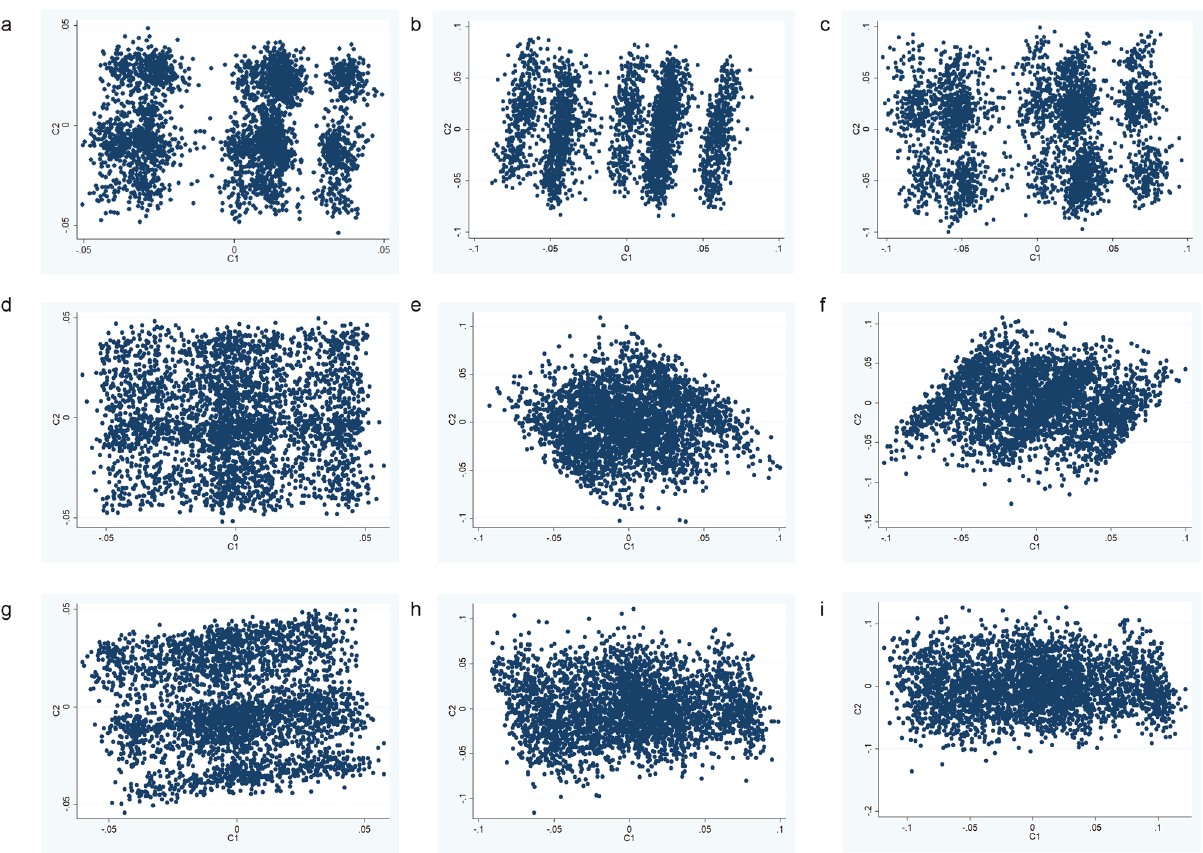
Figure 2. Results of MDS analysis in IMPROVE, using the loci in common between CMD and SCZ with ( a ) MAF > 1%, ( b ) MAF > 5% or ( c ) MAF > 10%; CMD and MDD with ( d ) MAF > 1%, ( e ) MAF > 5% or ( f ) MAF > 10%; CMD and BD with ( g ) MAF > 1%, ( h ) MAF > 5% or ( i ) MAF > 10%. Each data point is an individual therefore the individuals who are closer together are more genetically